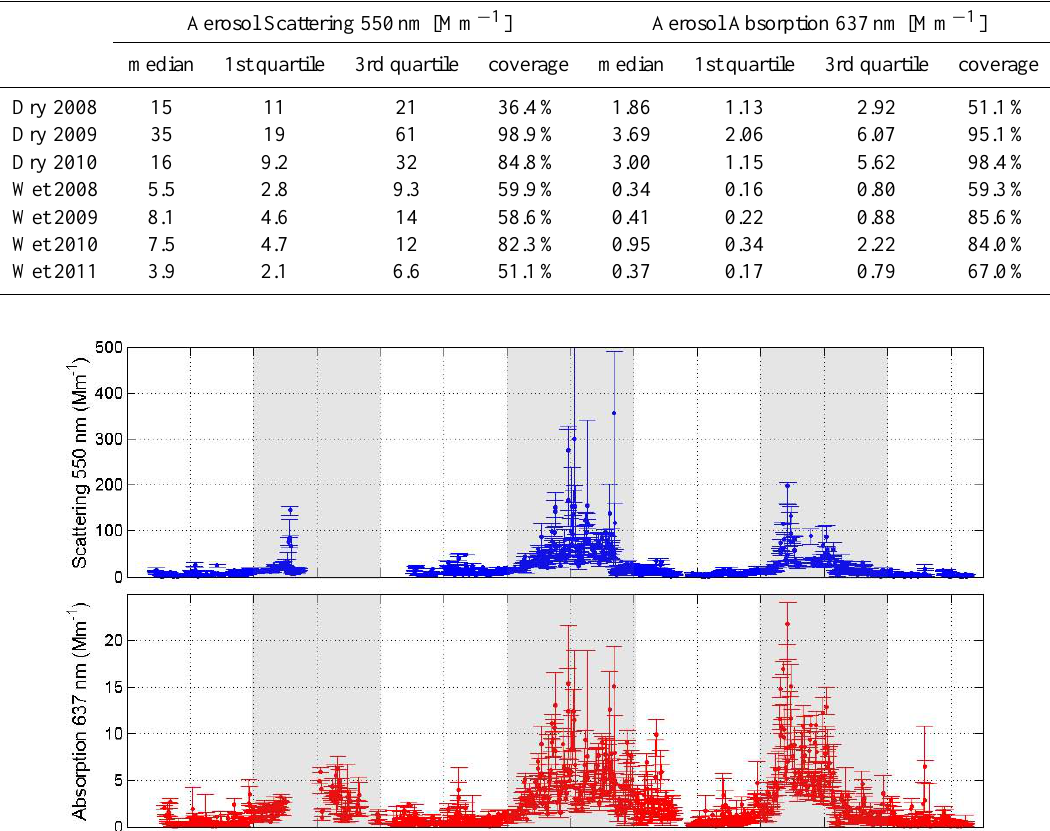
Table 5. Year to year and seasonal variability on aerosol particle scattering and absorption. The percent data coverage is also shown.